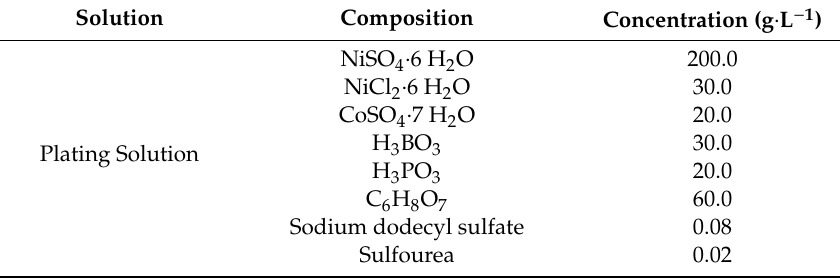
Table 2. Composition of the solution used in the preparation of Ni–Co–P alloy